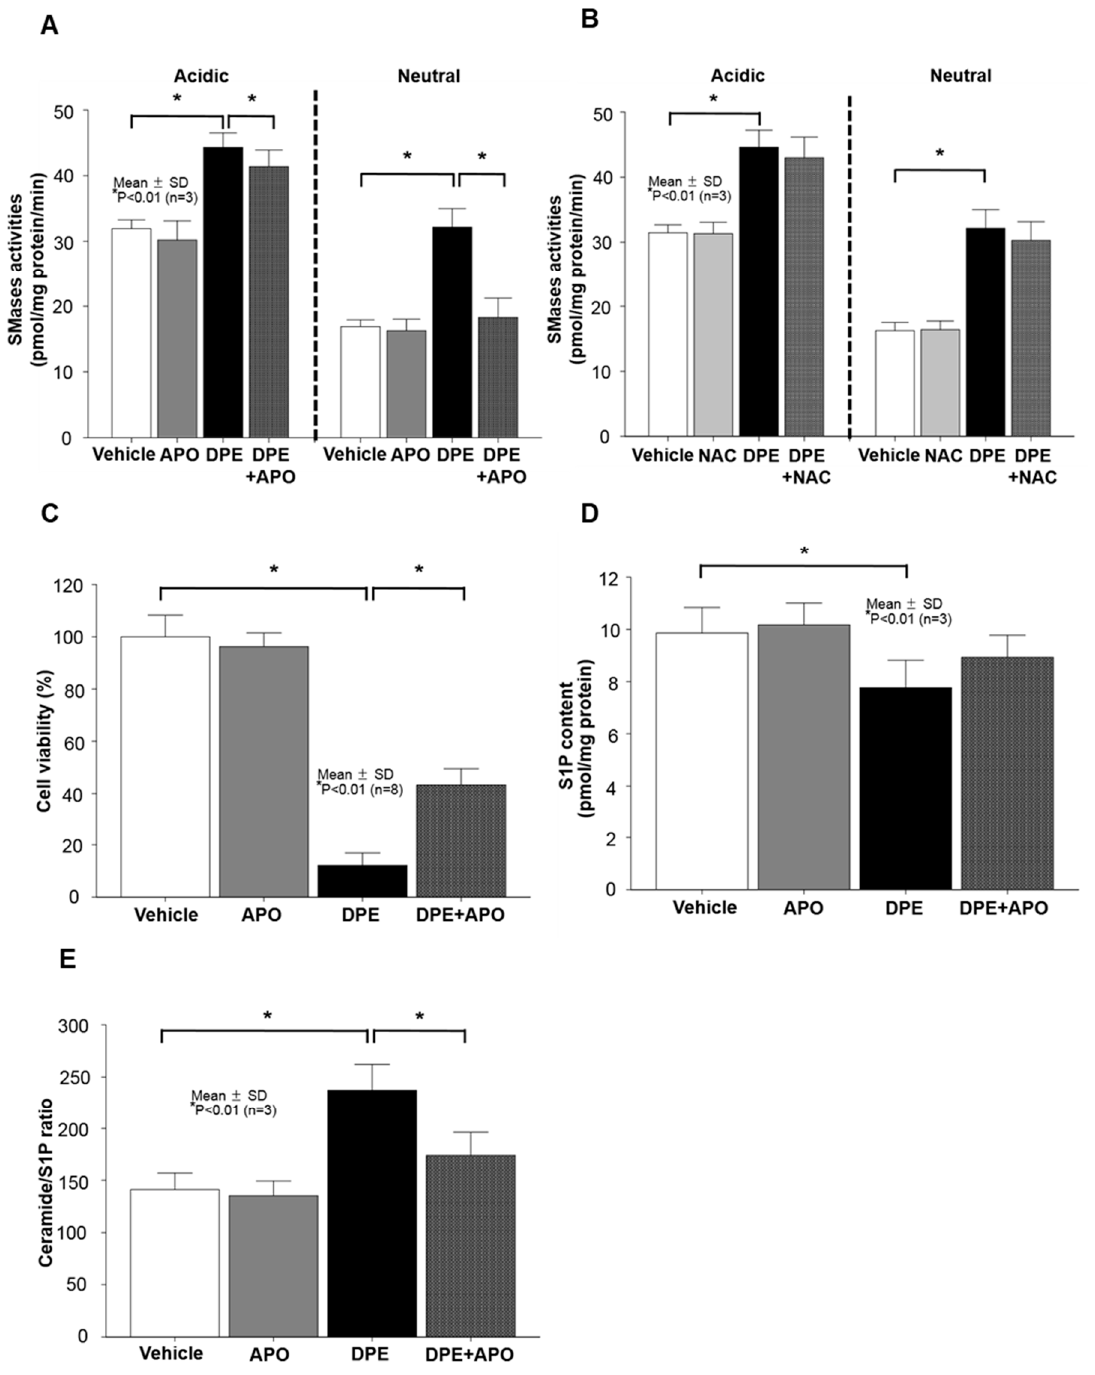
Figure 4. DPE-mediated activation of neutral sphingomyelinase (SMase) is required for NOX activation-induced increase in ceramide and subsequent KC apoptosis. Human KC pre-treated with or without NOX (Apocynin [APO], 100 μ M), ROS generation (N-Acetylcysteine [NAC], 1 mM), or GW4869 (neutral SMase inhibitor, 10 μ M) for 30 mins were incubated with DPE (100 μ g/mL) for 24 hrs. Activities of acidic and neutral SMases ( A , B ), and contents of ceramide and sphingosine-1-phosphate ( D , E ) were assessed by LC-ESI-MS/MS. Cell viability or cytotoxicity was measured by either WST-1 assay ( C ). All values are mean ± SD ( n = 3). Statistical significance was calculated using the unpaired Student’s t -test, and significance was defined as p < 0.01 vs. vehicle control (or untreated control).